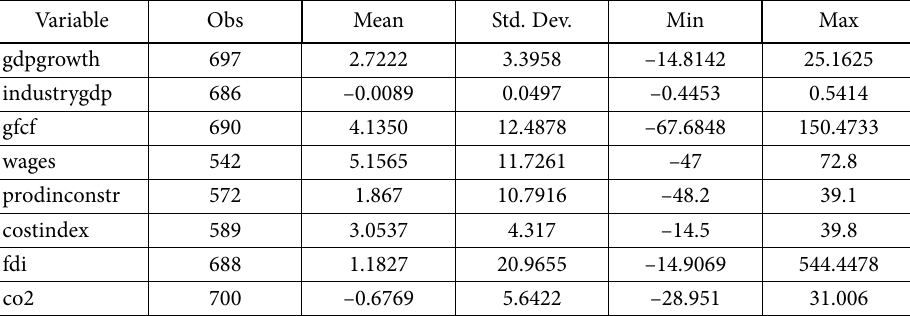
Table 2. Descriptive statistics (source: Stata, Authors’